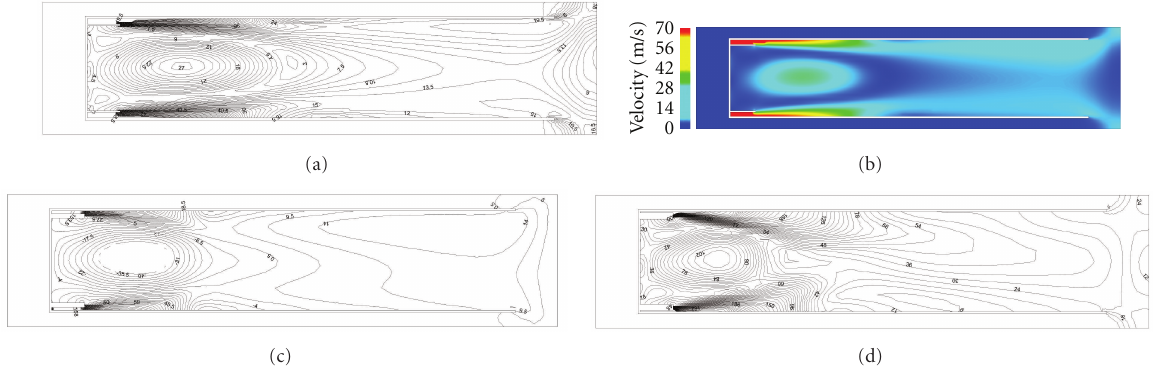
Figure 5: Isolines of the velocity V. (a) δ = 12 mm; (b) δ = 12mm; (c) δ = 6 mm; (d) δ = 2 .